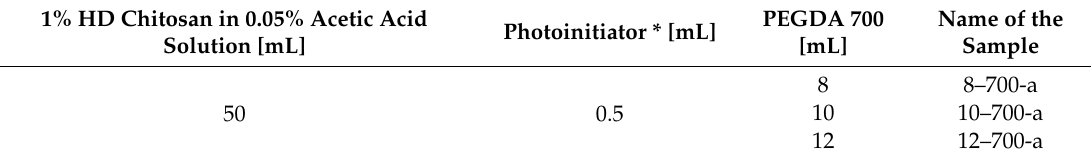
Table 3. Compositions of modified hydrogels prepared using PEGDA